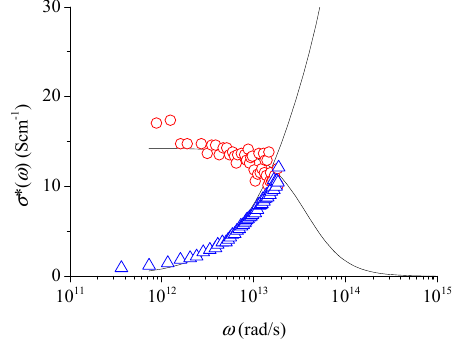
Figure 8. Complex conductivity in single crystalline epitaxial ZnO films. Open circles and triangles are the experimental data extracted from [31]. Solid lines are the conductivity predicted from the SSFTC model.